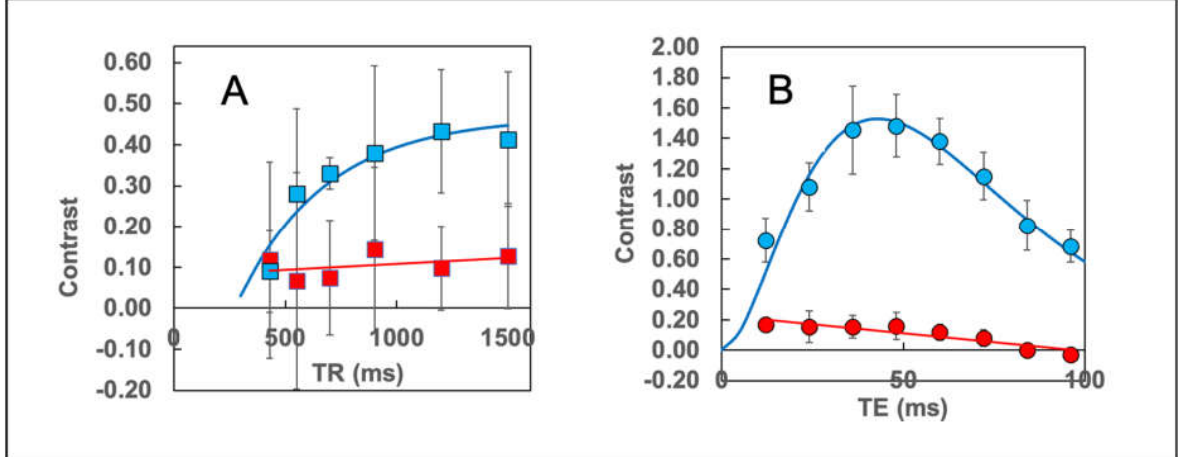
Figure 4. The relationship between the tumor/muscle contrast and the MR imaging parameters in the absence of SPIONs (Blue symbols) and in their presence 24 h later (Red symbols). ( A ) Contrast data obtained using a set of T 1 w RAREvtr images (T E = 14 ms). The blue curve is a fit to the T 1 relaxation equation, C(t) = M o (1 − 2 e −t/T1 ), with M o = 0.4677, and T 1 = 395.3 ms, prior to SPION injection. The red line is a least squares fit, C(t) = 2.98 × 10 −5t + 7.84 × 10 −2 , obtained 24 hours post-injection. ( B ) Contrast data obtained using a set of T 2 w MSME images (TR = 2.515 ms). The blue line is a fit to a gamma variate function, C(t) = A t 2 e −(t − t0)/th2 , with A = 0.009181, t 0 = −8.672 ms, and t h2 = 21.48 ms, prior to SPION injection. The red line is a least-squares fit, C(t) = −0.0024 t + 0.2296, obtained 24 hours post-injection. Note how strongly the SPION quench the contrast in T 2 w images (Red line). Also, the fitted contrast function (blue line) peaks near an echo time of 43 ms, which is close to the predicted maximum (see Section 2) of 60 ms.